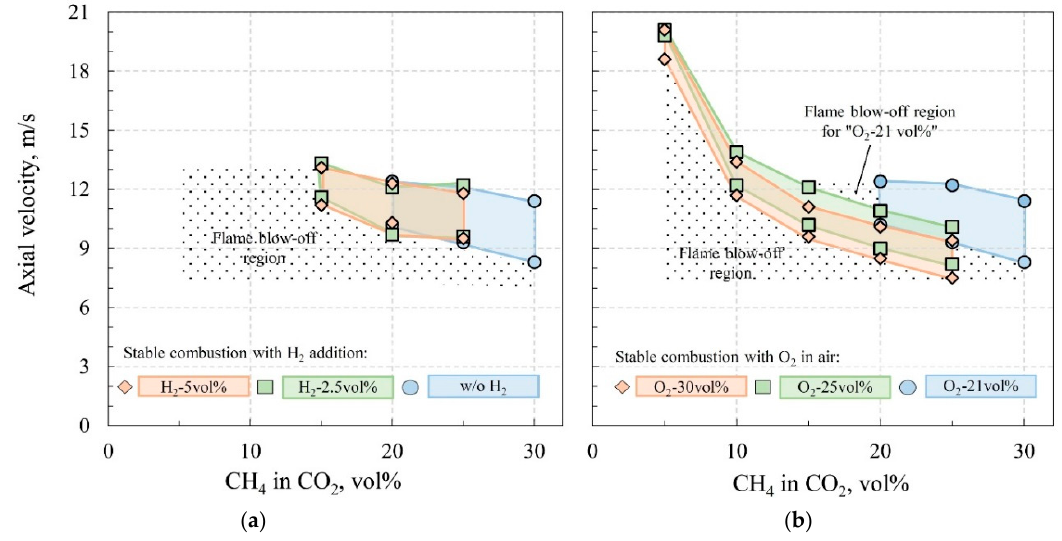
Figure 5. Axial velocity ranges during waste biogas (LCV) combustion with different content of CH 4 in CO 2 for a range of ( a ) H 2 addition and ( b ) O 2 air enrichment. The upper and bottom limit stands for a ϕ max and ϕ min , respectively.